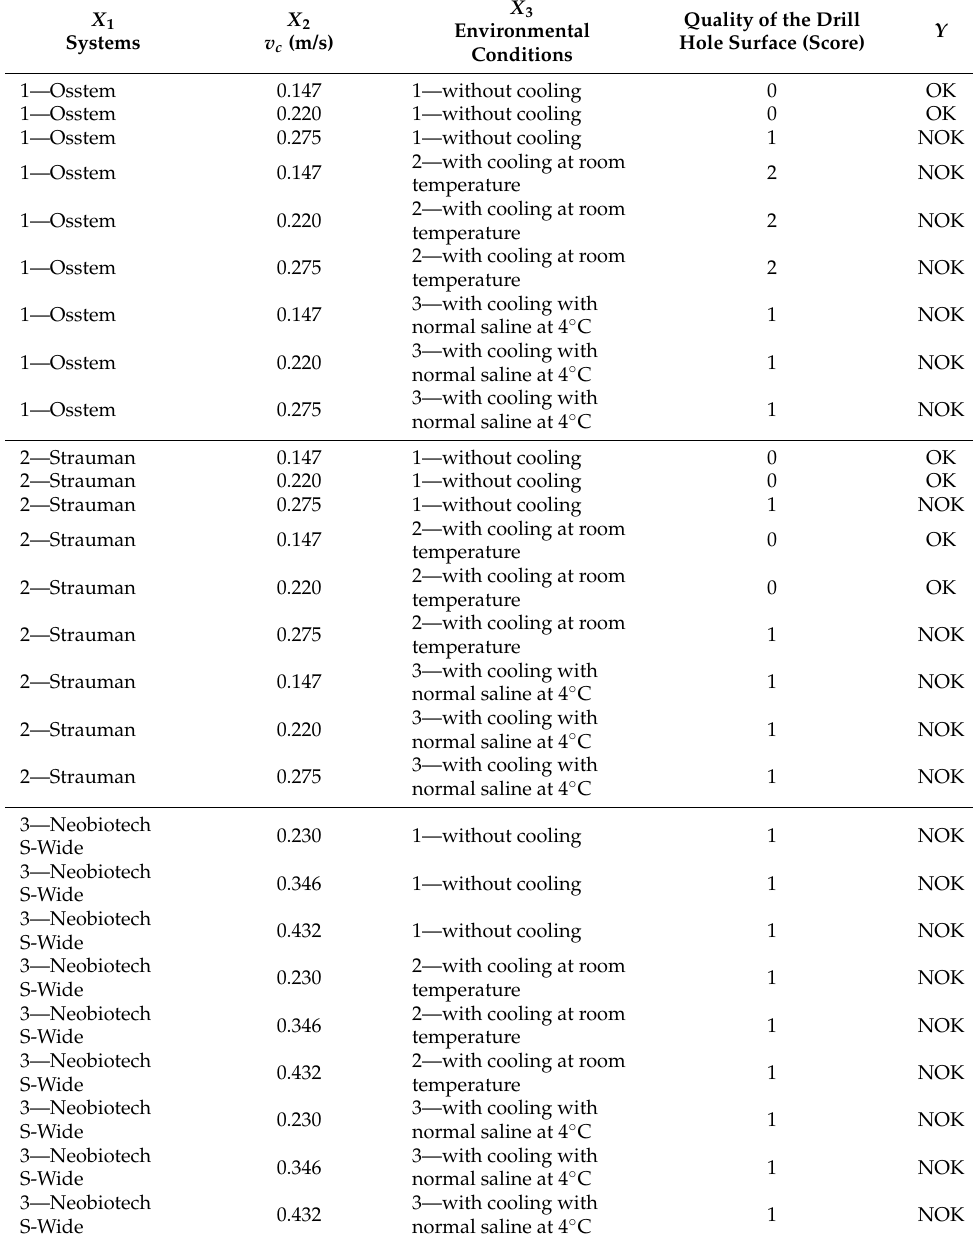
Table 1. Results of scoring in microscopic